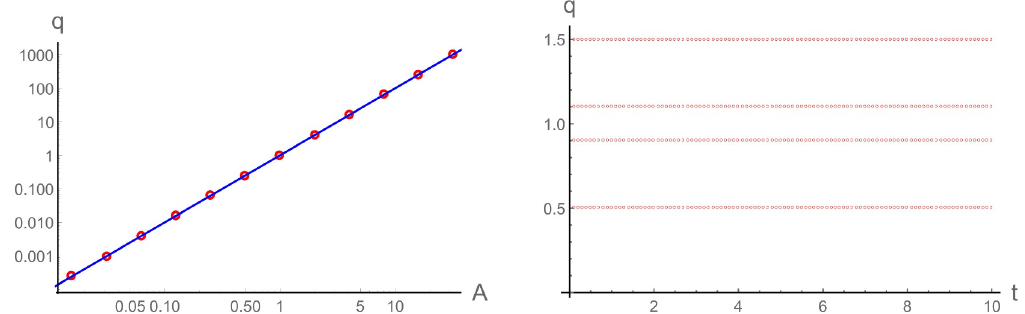
Figure 2 . The ratio test for the perturbative sector in position space for initial data (2.17). Left: the ratio q defined in (2.19) vs. maximum support of the initial data in momentum space, A , at t = 1 . Right: q vs. t for different values of A ; from top to bottom, A 2 = 1 . 5 , 1 . 1 , 0 . 9 and 0 . 5 .